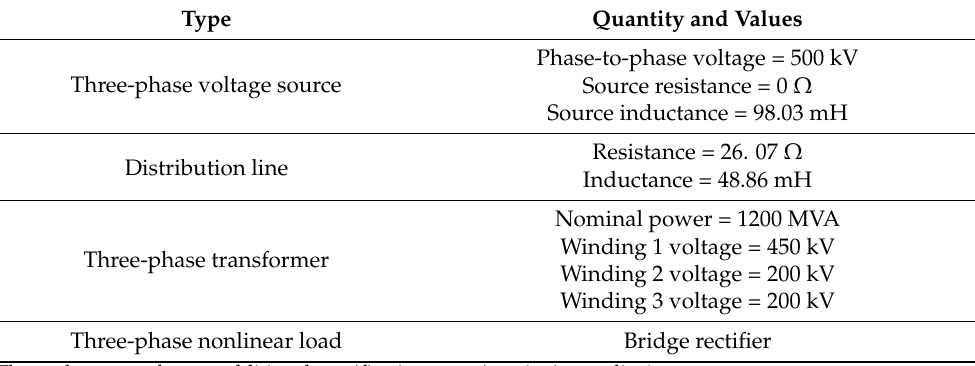
Table 1. Technical Specifications of the system.